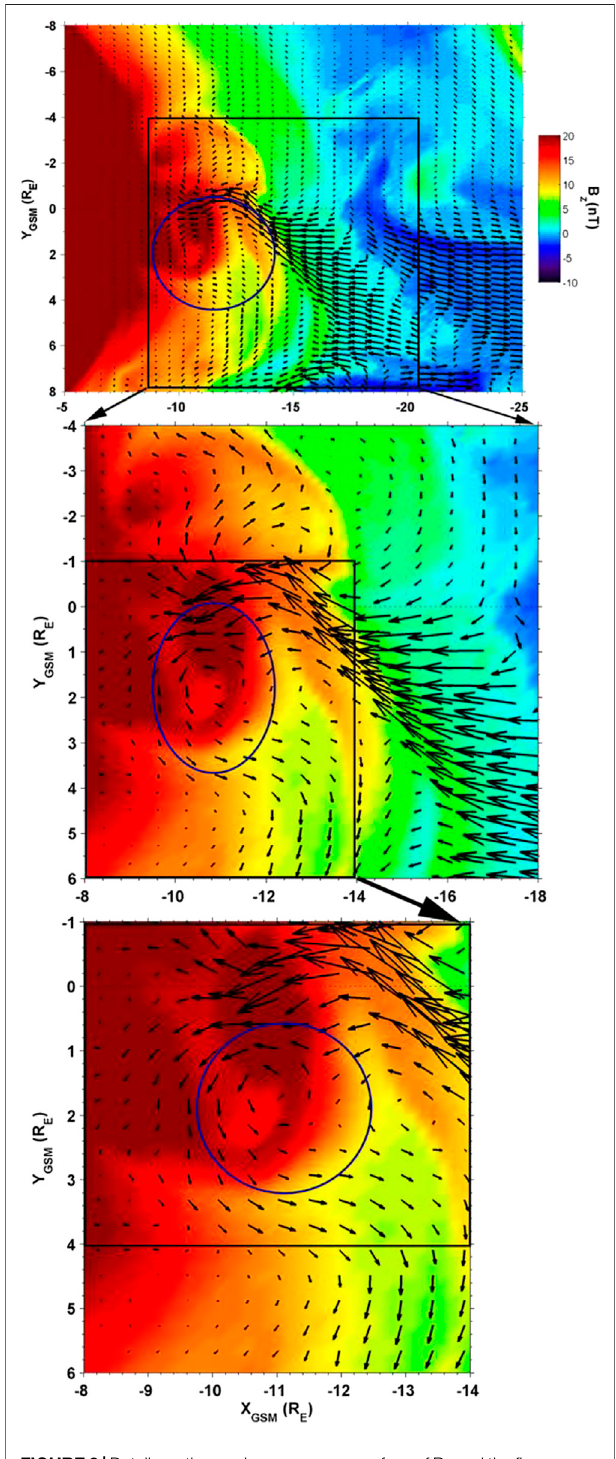
FIGURE8| Detailsonthe maximum pressure surfaceofBzand the fl ow showing vortices at 0407 UT. Vortices occur on multiple time and spatial scales. (After El-Alaoui et al.,